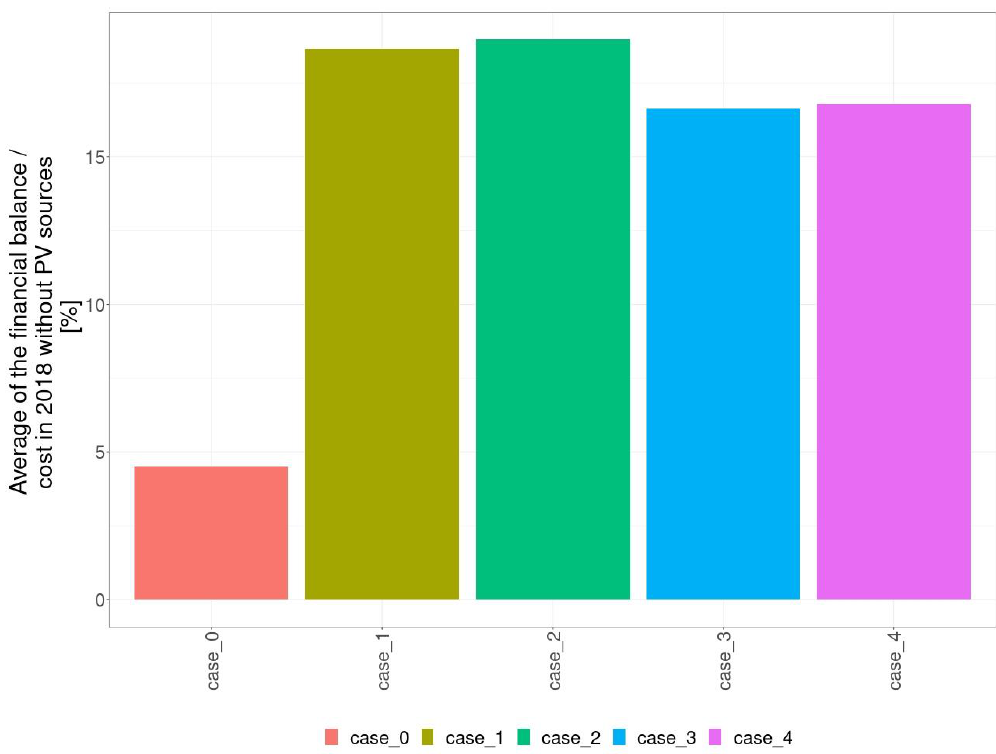
Figure 8. Share of the averaged balance of energy purchase costs for the whole analysis period and all prosumers in relation to the energy purchase costs in 2018 prior to obtaining the status of prosumers. A slightly more precise inference can be made by analyzing each year separately, as presented in Figure 9.